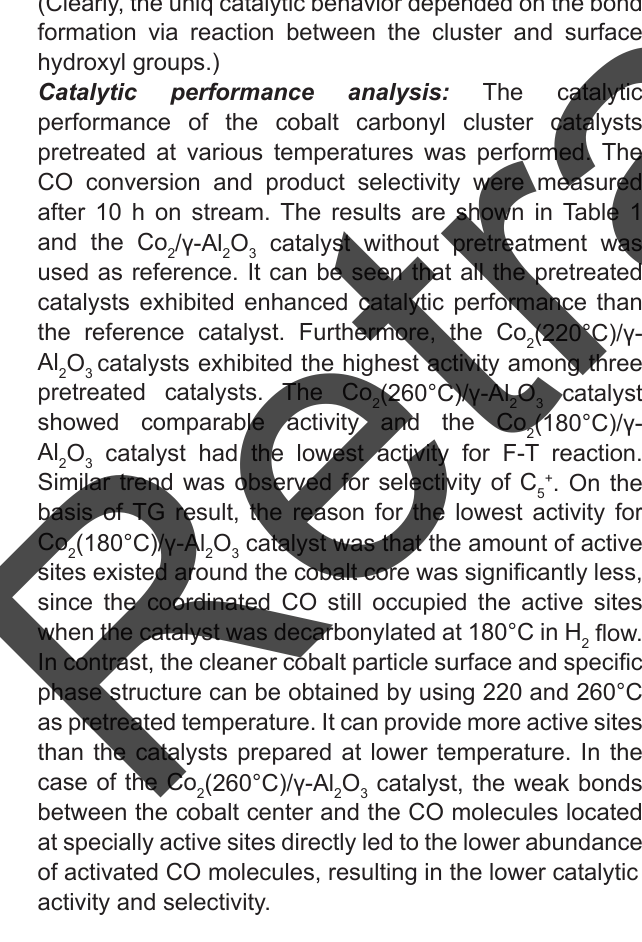
(b) Co /Al O ; (c) γ-Al O 2 2 3 2 3